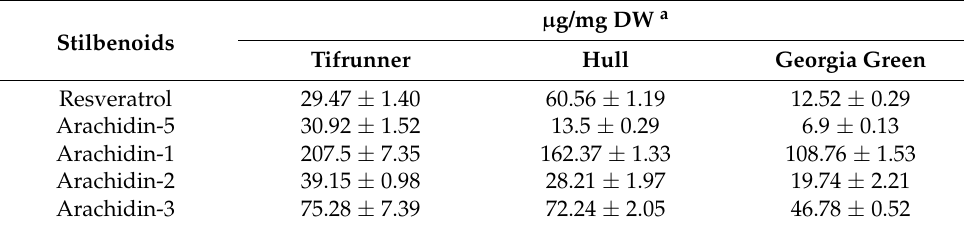
Table 2. Amount of stilbenoid per dry weight of the extract (µg/mg) in three different cultivars of peanuts.